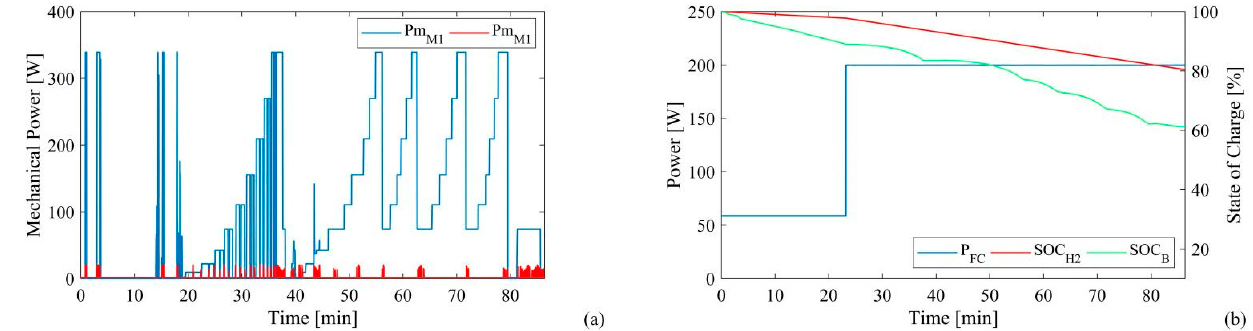
Figure 10. AMV performance in Journey 2: ( a ) Motor mechanical power trends; ( b ) Fuel cell power, hydrogen tank and battery state of charge trends.